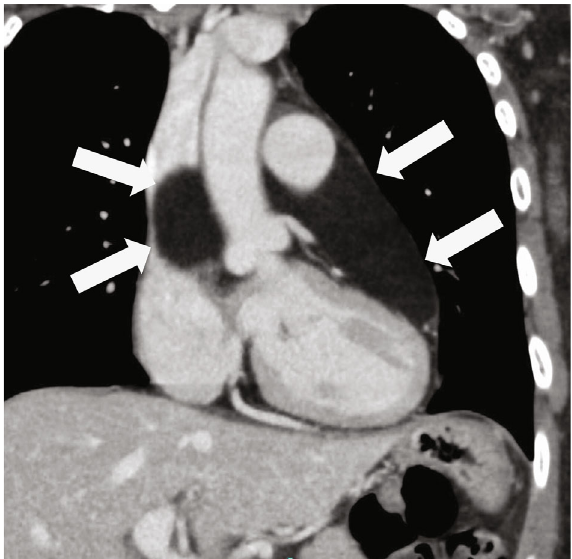
Figure 1: Preoperative enhanced computed tomography image. A mass on the posterior surface of the ascending aorta and main pulmonary artery is shown.